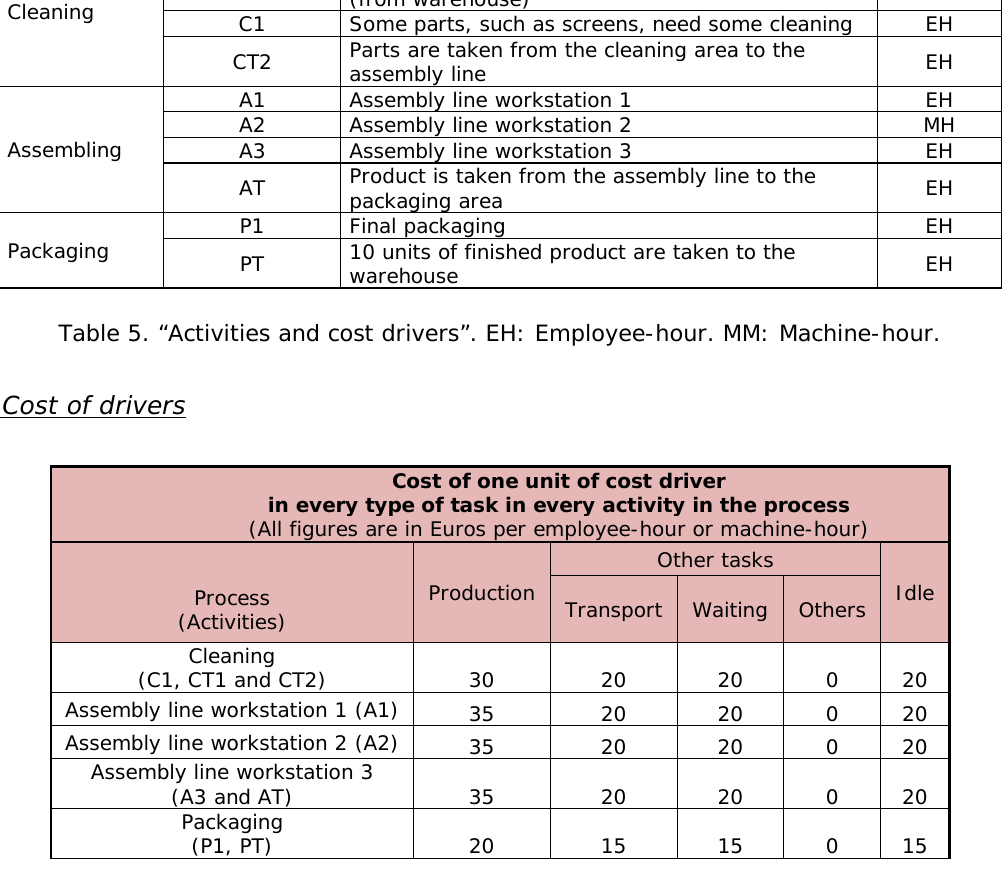
Table 6. “Cost per unit of cost driver, according to the type of task in